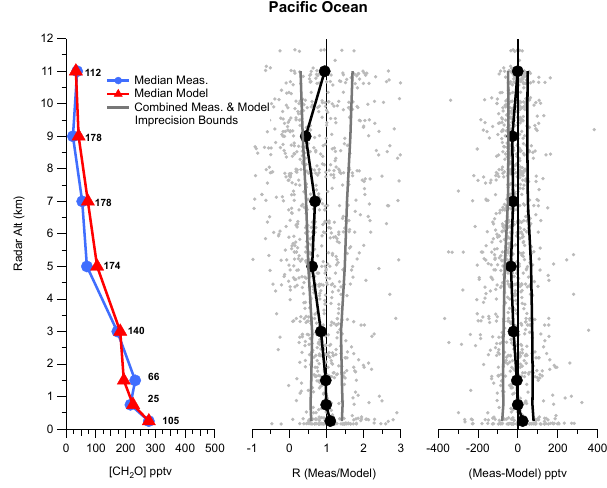
Fig. 8. Time coincident comparisons on hydrocarbon time base over the Pacific Ocean during the 2nd phase of INTEX-B. This plot has the same format as Figs.